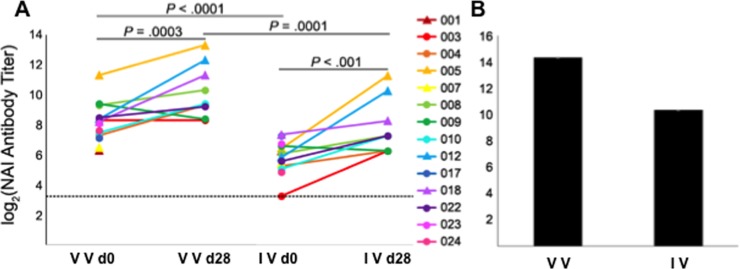
Effect of mutations present in the NA of 2015–2016 isolates on the antigenicity of the protein.ELLA assays using human (A) and ferret antisera (B). Standardized antisera from ferrets infected with the vaccine virus, and human sera collected from infected subjects at the acute (day 0) and post-acute visits 28 days later (day 28), were measured using ELLA for NAI antibodies specific for the NA protein of the vaccine strain and the virus isolated from patient 001, which encodes mutations found in the majority of 2015–2016 isolates circulating worldwide. Individual subject numbers from which the viruses were isolated are shown in the legend. Subjects whose titers are represented with circles received the 2015–2016 flu vaccine, while those represented with triangles were not vaccinated. Experiments were repeated three times, showing reproducible data. IV, isolated virus. VV, vaccine virus. The LoD is indicated by the dotted line. Experiments were repeated 3 times, showing reproducible data.